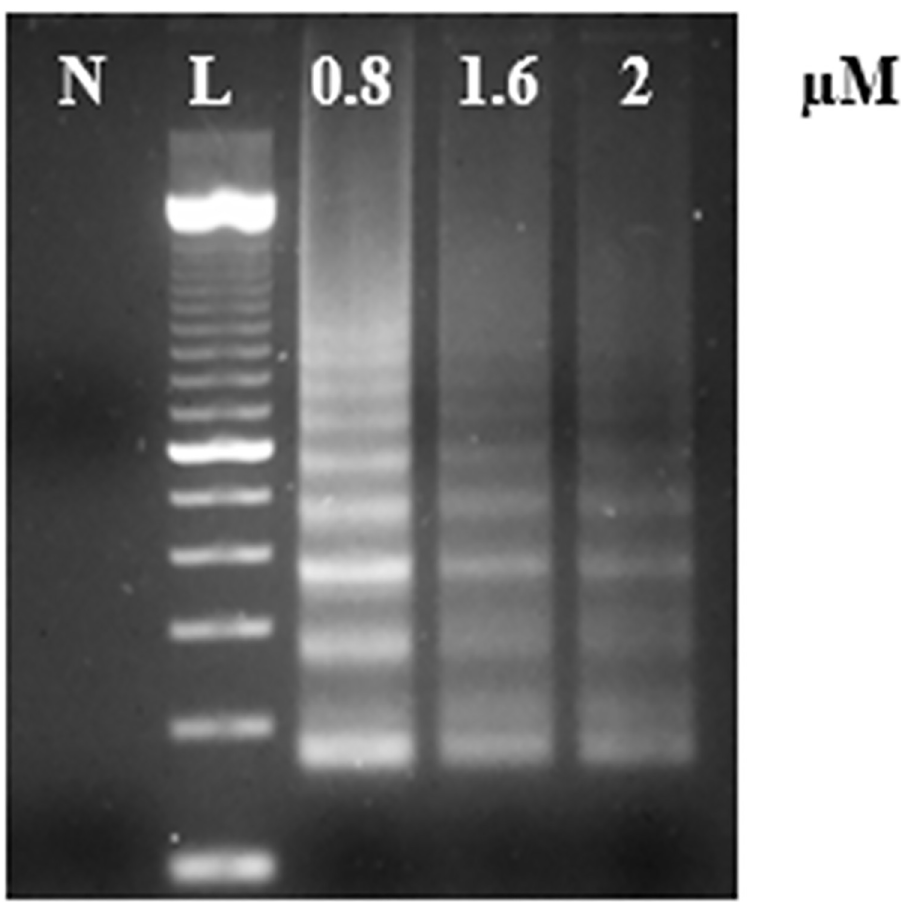
Fig 2. Optimization of the primer concentration using the outer LAMP primers RRVP3-FIP and RRVP3-BIP, the RRV-P3 plasmid as a template, and Bst 2.0 DNA Polymerase. Lane N, is a non-template control (NTC, water); lane L, is a 100 bp DNA